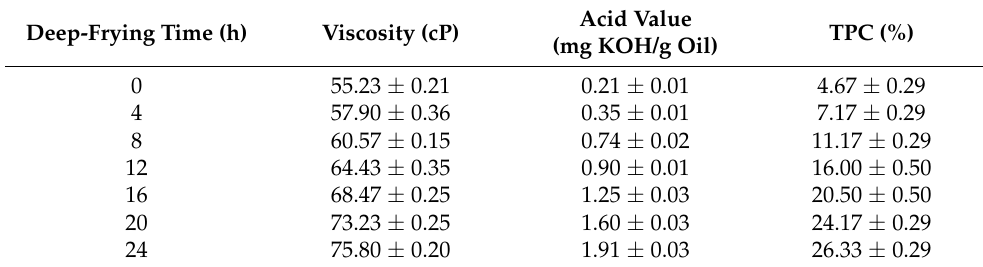
Table 3. Viscosity, AV, and TPC during deep-frying